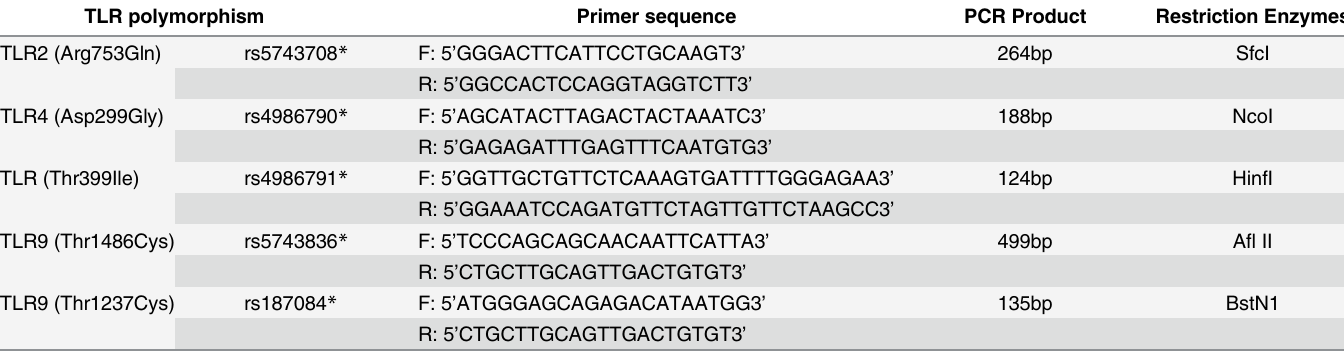
Table 1. Nucleotide sequences of synthetic oligonucleotides for PCR-based RFLP for single nucleotide